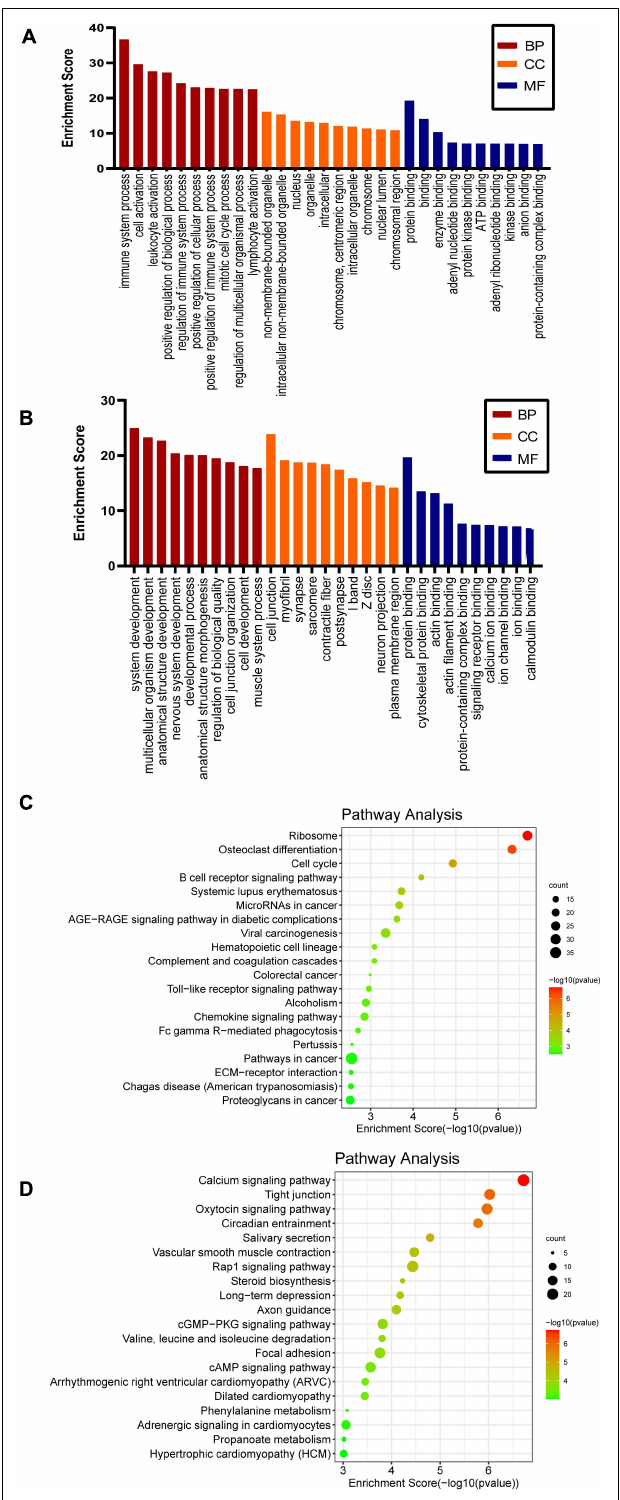
FIGURE 3 | GO and KEGG pathway analyses of the differentially methylated genes. Significantly enriched GO terms of the hypermethylated (A) and hypomethylated genes (B) . Significantly enriched KEGG pathways of the hypermethylated (C) and hypomethylated (D)